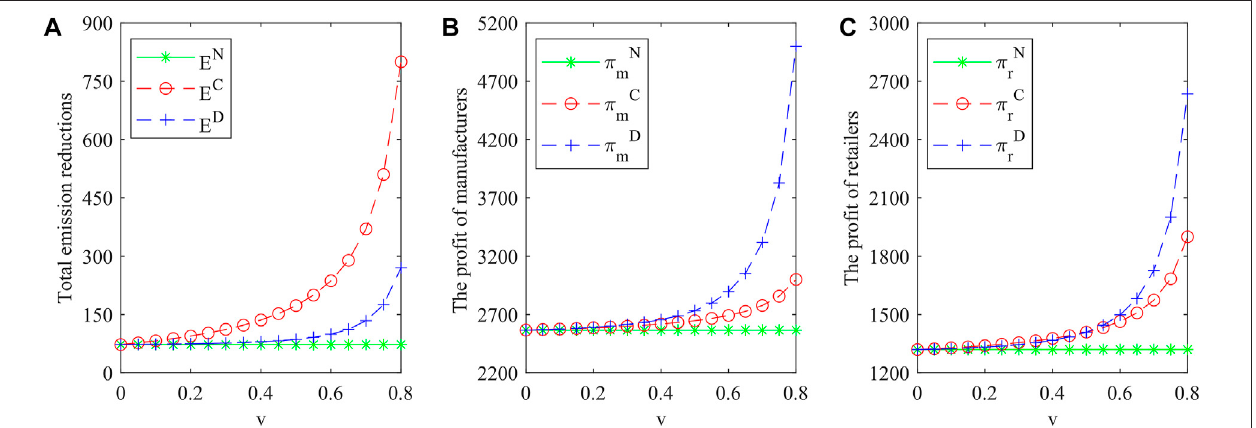
FIGURE 1 | Impact of different government subsidy methods on E j , π j m , and π j r . (A) Impact of different government subsidy methods on total emission reductions. (B) Impact of different government subsidy methods on manufacturers ’ pro fi ts. (C) Impact of different government subsidy methods on retailers ’ pro fi ts.